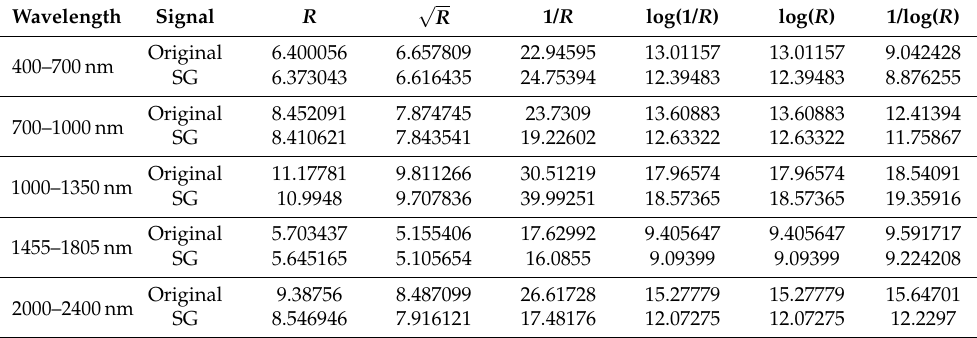
Table 3. The ratio of performance to deviation (RPD) value of the PNN model in Area